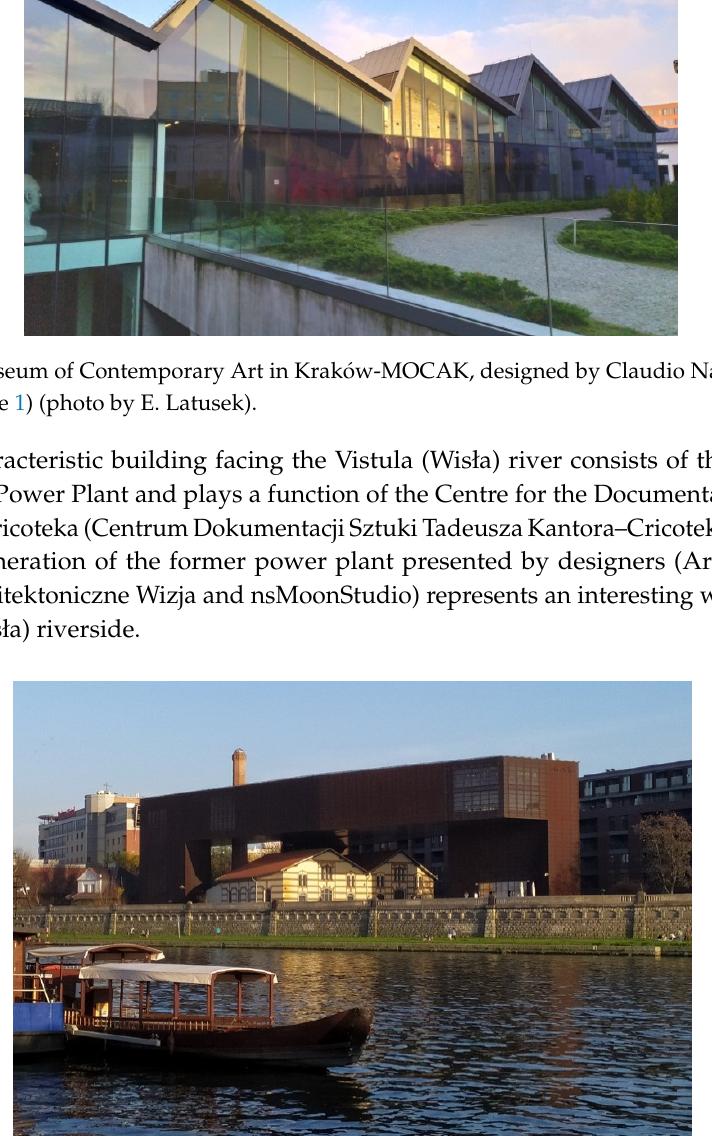
Architektoniczne Wizja and nsMoonStudio (Item 10, Figure 1), (photo by E. Latusek).